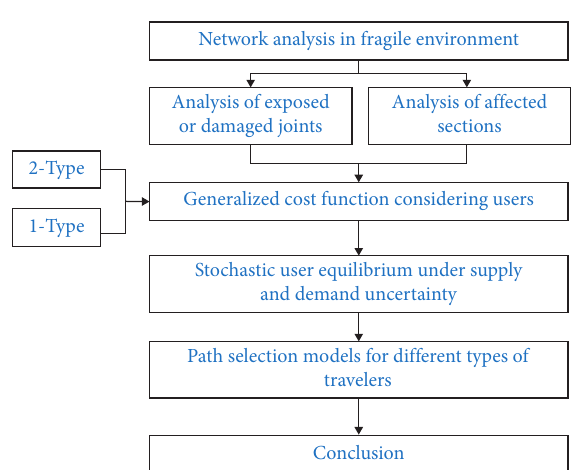
Figure 2: Outline of the proposed